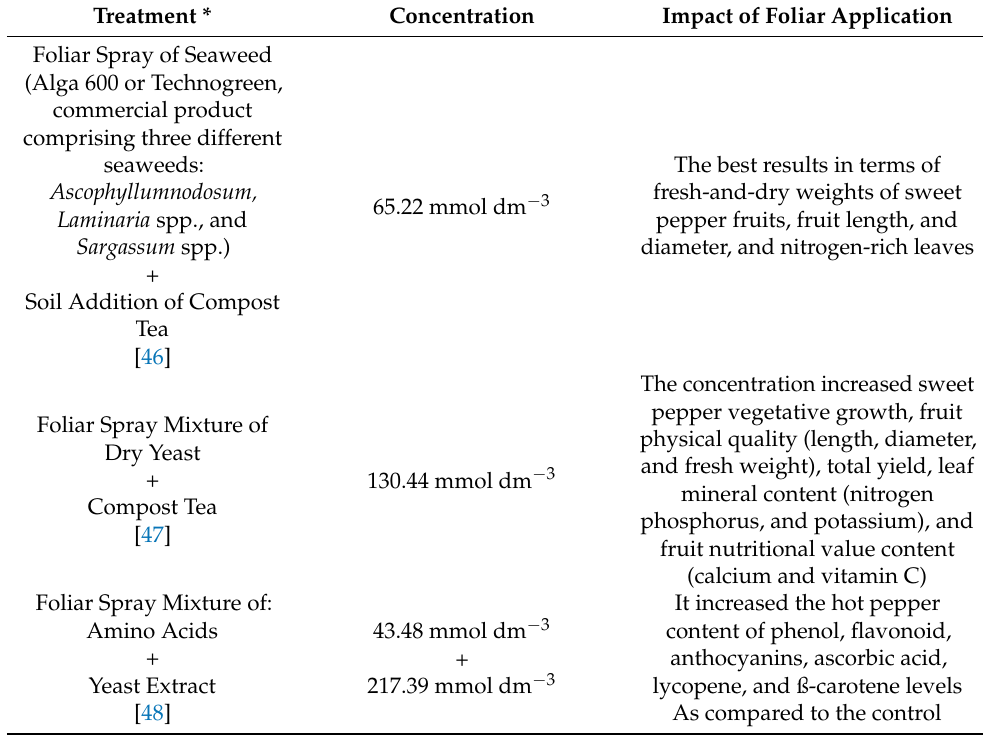
Table 7. Impact of foliar nutrition with biological treatments in